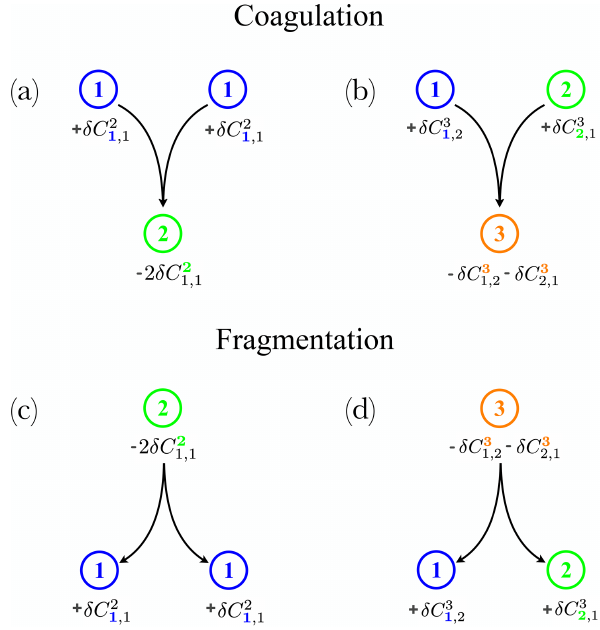
Figure 2. Examples of individual reactions for a triplet of bins: (a,b) for coagulation only, assuming F = 0 and (c,d) for fragmen- tation only, assuming K = 0 in Eq. (9). Panels on the left (a,c) in- volve terms of the diagonal matrix D i = j (Eq. 10), while panels on the right (b,d) involve terms of the off-diagonal matrices B (Eq. 11) and T (Eq. 12) in Sect. 2.3. Different colours (blue, green and black) represent different size